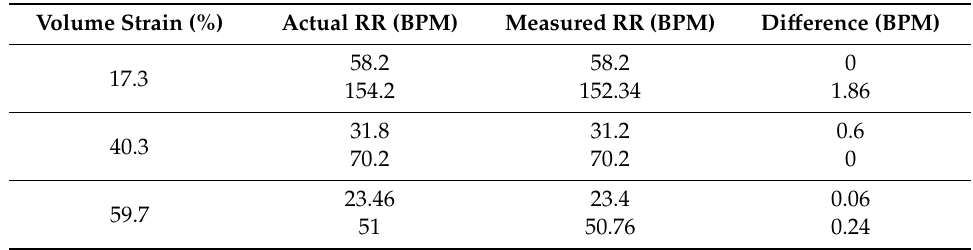
Table 4. The measured respiratory rate by IJP PDMS-based sensor compared with the actual one using the respiratory simulator at different volume strains.